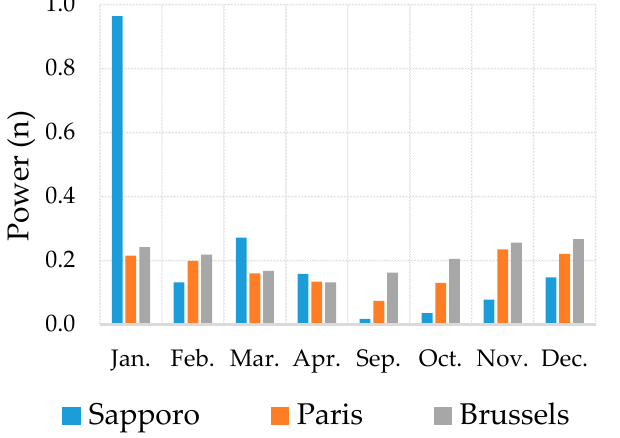
Figure 15. Monthly power values for different climates corresponding to the reference Tallinn climate. The monthly normalization worked reasonably well (the power factor close to 0.2) when monthly climate differences were reasonably similar to the annual climate differences. For Sapporo, this was not the case for January, whereas other months showed consistent results. In the Sapporo case, a power factor of 0.96 for January was explained by colder outdoor temperatures in January, while the annual outdoor temperature value was lower for Tallinn. For all other months, the outdoor temperature was higher in Sapporo, as shown in Figure